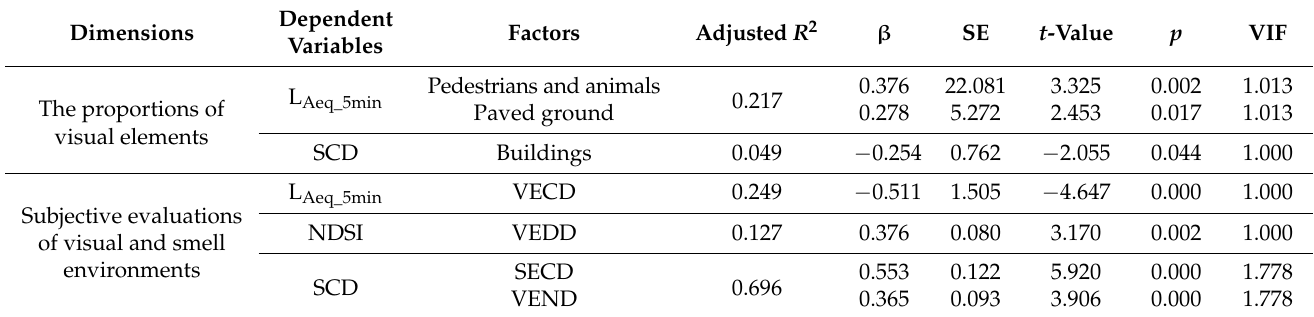
Table 10. Results of multiple linear regression analyses for the proportions of visual elements and subjective evaluations of visual and smell environments with soundscape evaluation